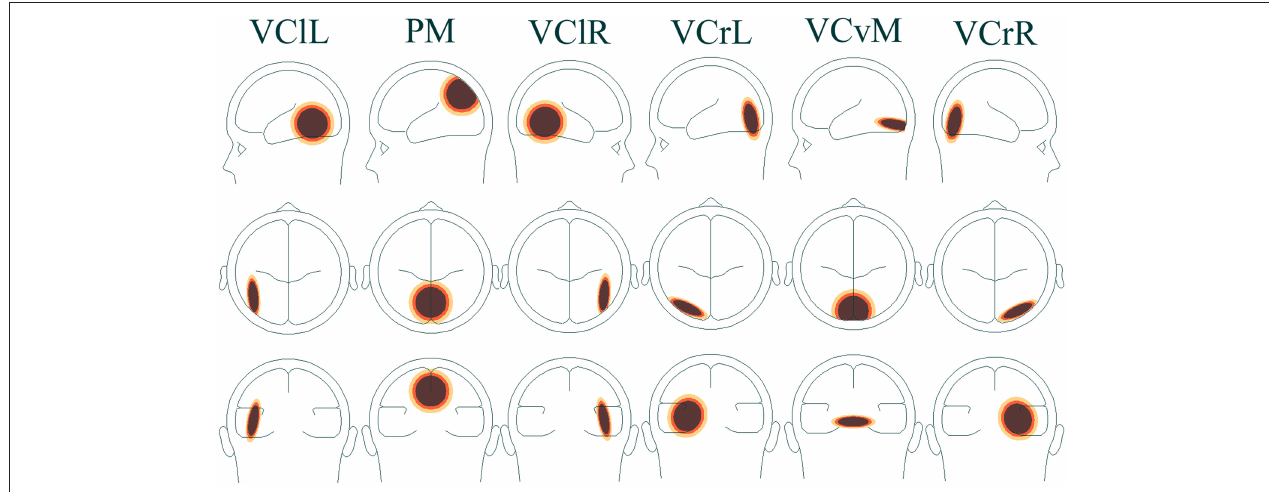
FIGURE 2 | Head model of associated brain regions in visual cortical areas VClL, VClR, VCrL, VCvM, VCrR, and visual parietal area